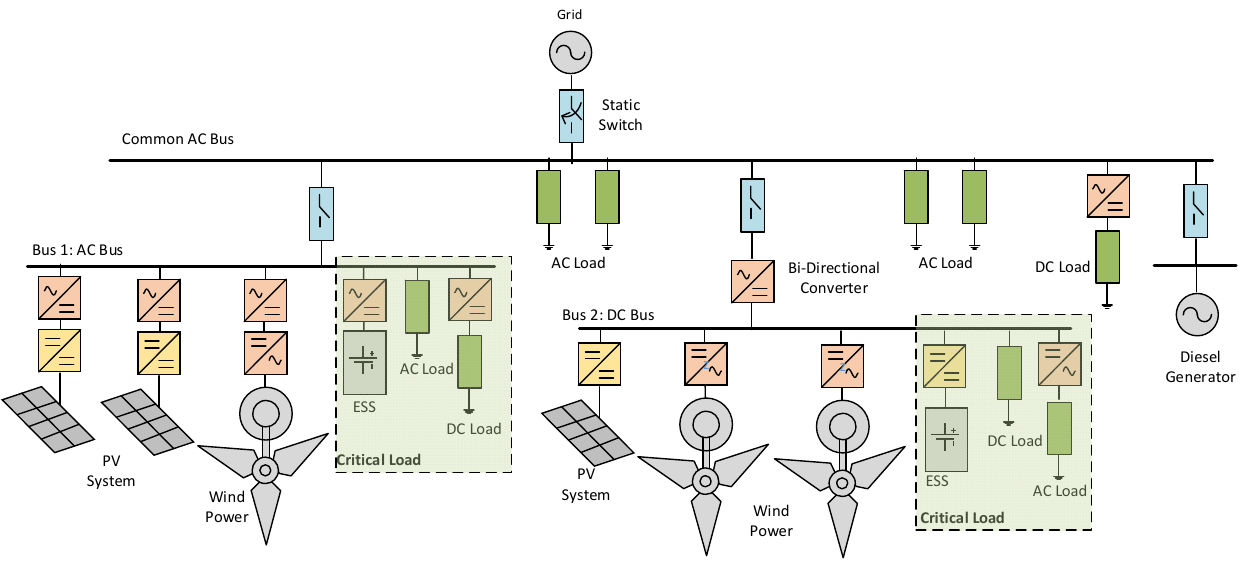
Figure 3. AC-DC microgrid architecture.